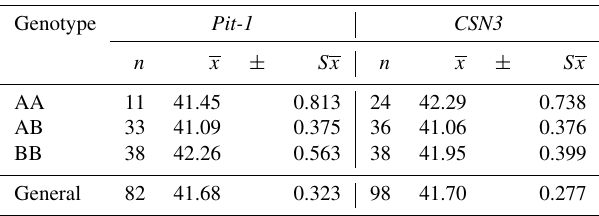
Table 6. The least squares means and standard errors of the Pit-1 and CSN3 genotypes in terms of calf birth weight